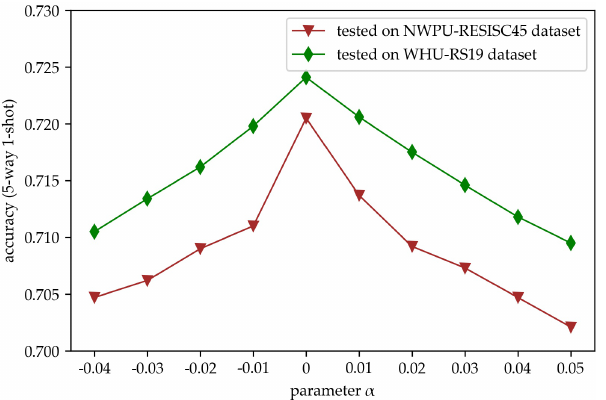
Figure 8. Accuracies with the changing of α tested in the case of 5-way 1-shot.